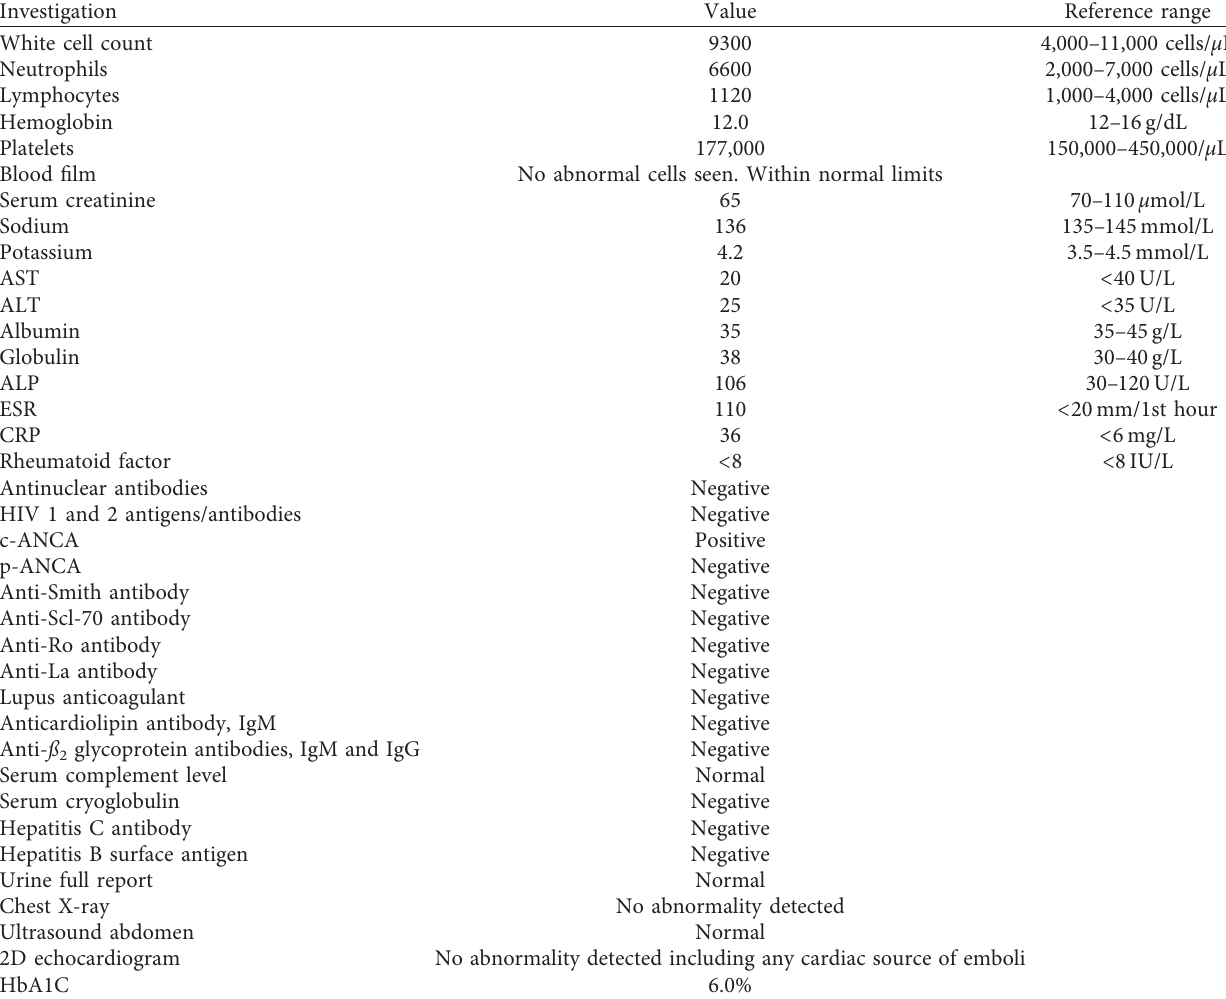
Table 1: Summary of